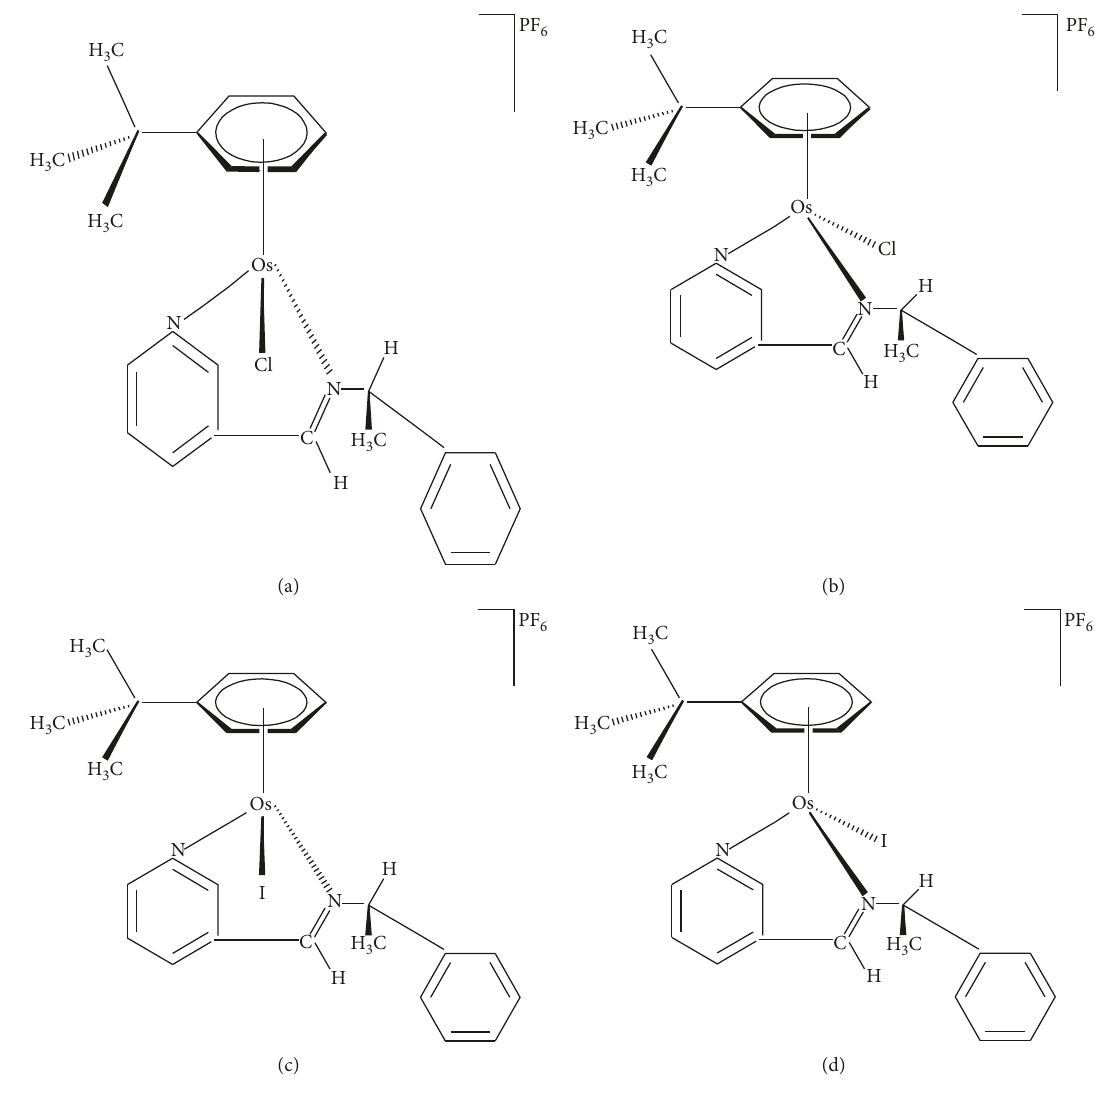
Figure 5: Chloro and iodido Os(II) arene anticancer complex.